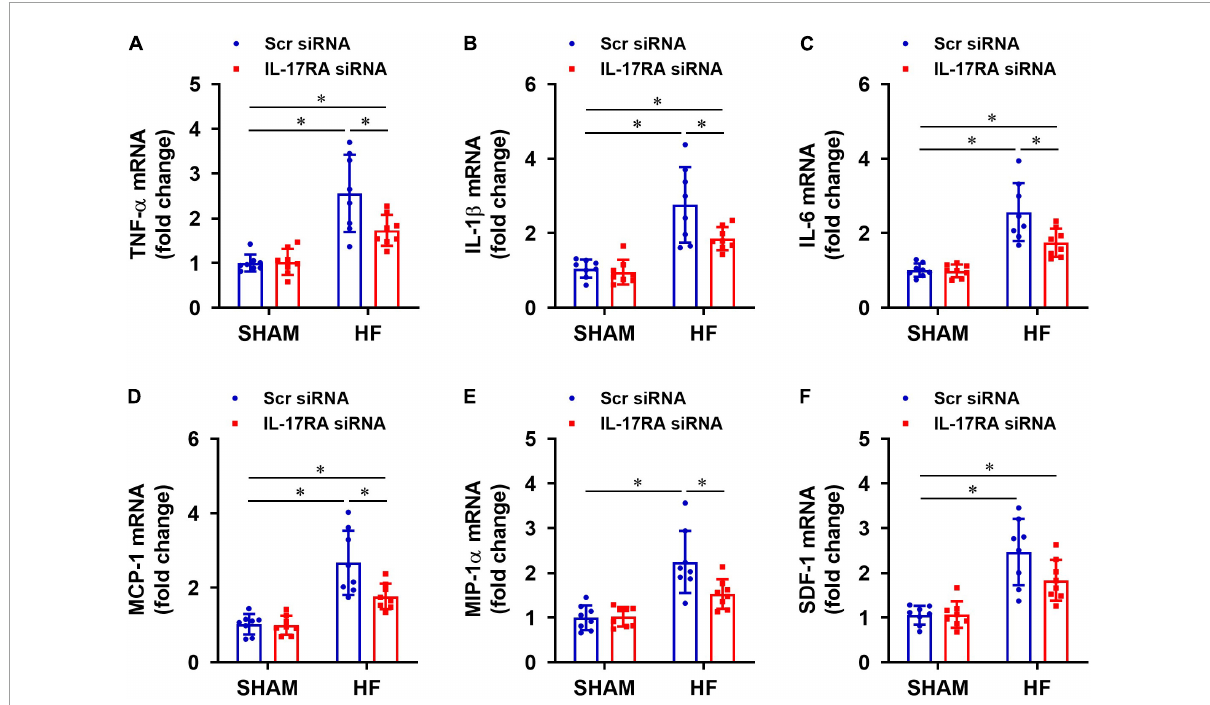
FIGURE4 Effect of bilateral PVN microinjection of IL-17RA siRNA on mRNA expression of proinflammatory cytokine tumor necrosis factor (TNF)- α (A) , interleukin (IL)-1 β (B) and IL-6 (C) , and on mRNA expression of chemokines monocyte chemoattractant protein-1 (MCP-1, D ), macrophage inflammatory protein-1 α (MIP-1 α , E ) and chemokine stromal cell-derived factor-1 (SDF-1, F ) in the PVN of SHAM and HF rats 4 weeks after CL. Scr: scrambled siRNA. Values are mean ± SEM ( n = 8 for each group) and are expressed as a fold change compared to SHAM + Scr siRNA; * p < 0.05.